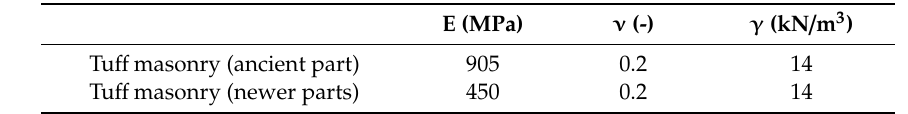
Table 1. Characteristics of the masonry.